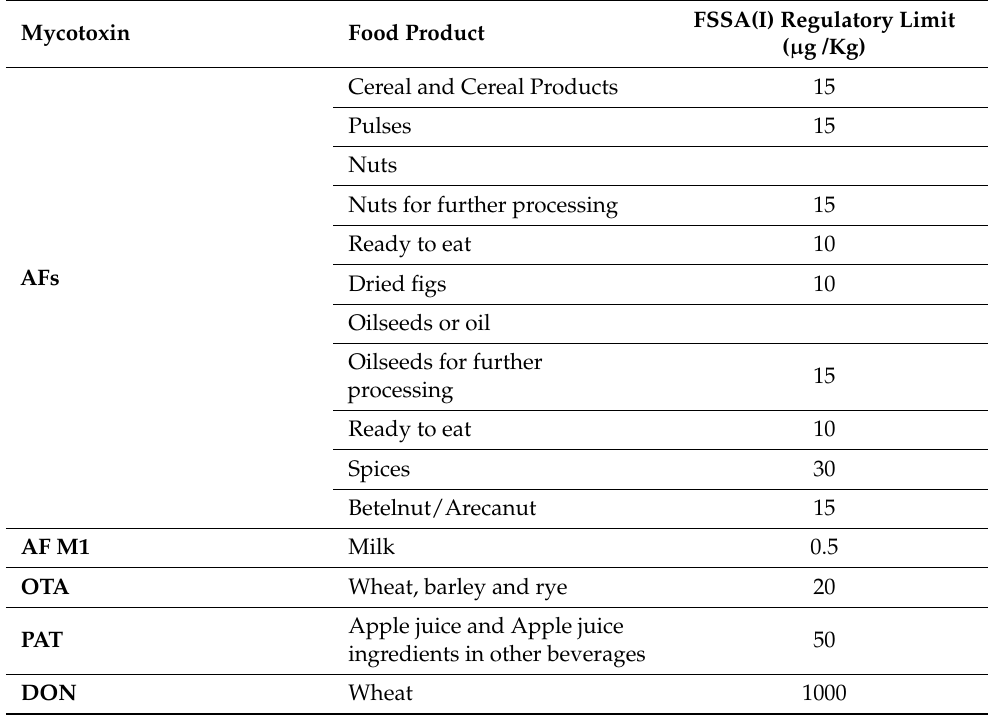
Table 1. Current FSSAI regulatory limits for mycotoxins in